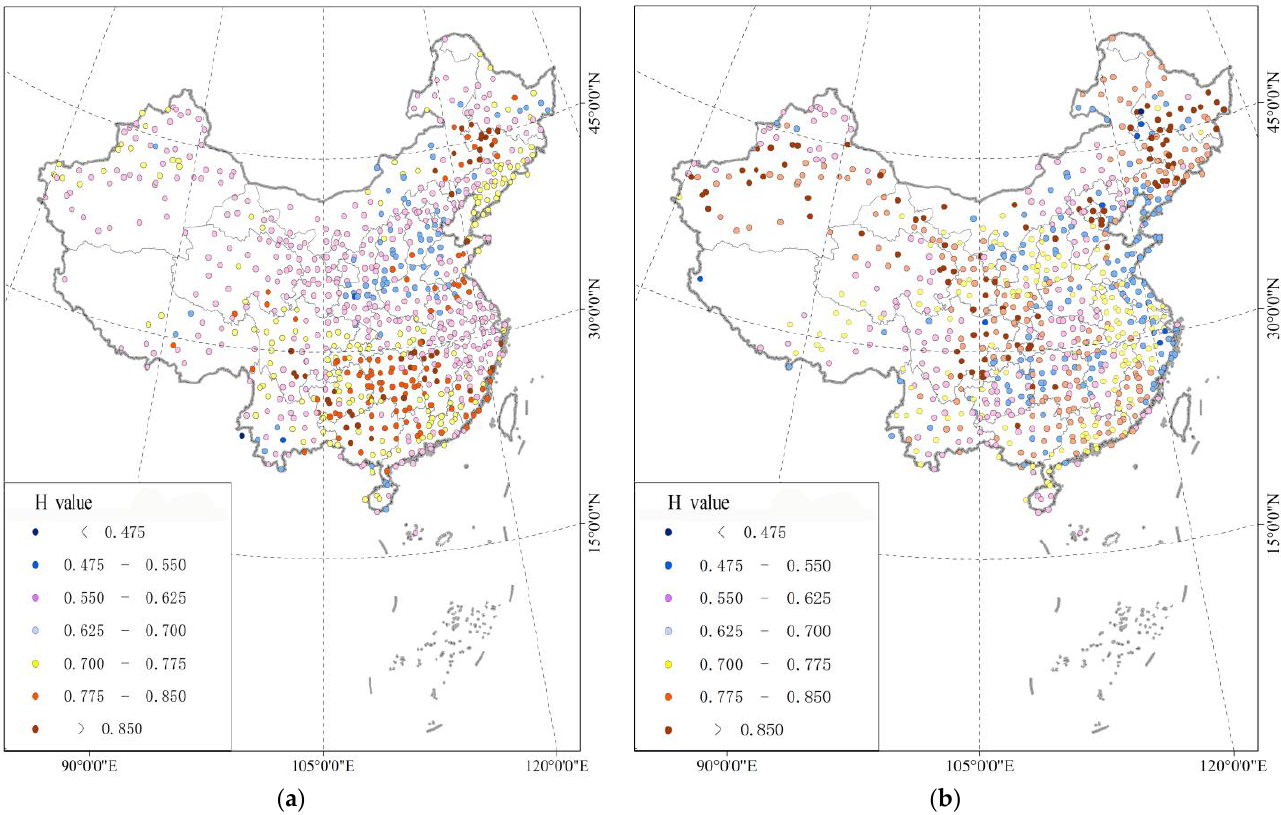
Figure 12. Spatial distribution of H values for CTXx and CTNn from 1966 to 2015. ( a ) CTXx. ( b )